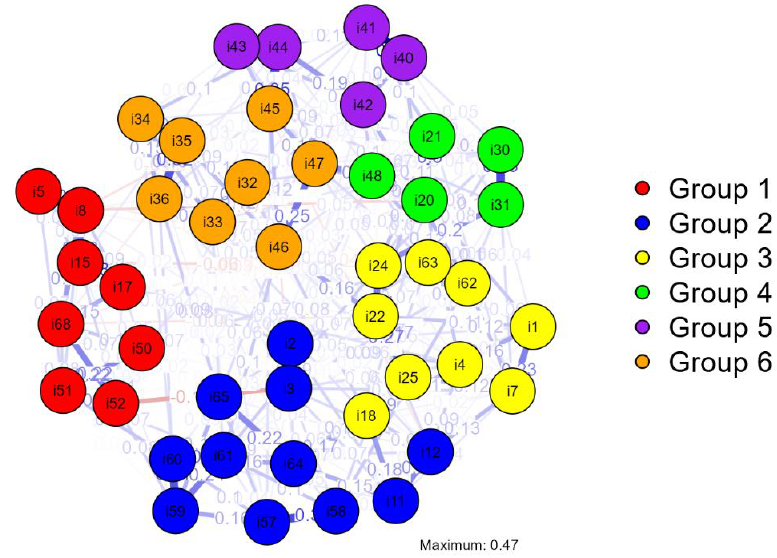
Figure 3. Network of the 46 items of BCPS.